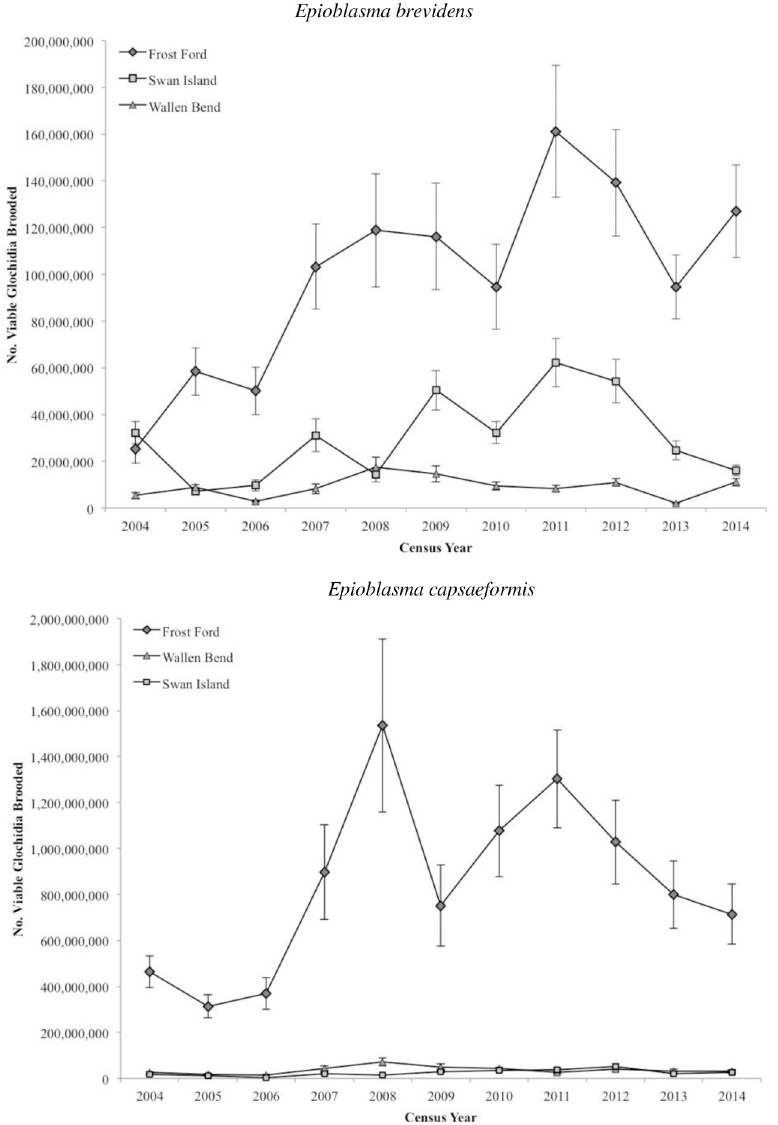
capsaeformis and available to host fishes at Swan Island, Frost Ford, and Wallen Bend in the Clinch River, Hancock County, TN, from 2004–2014. Numbers were estimated based on annual number of mature females per site and the fecundity-length relationships in Fig